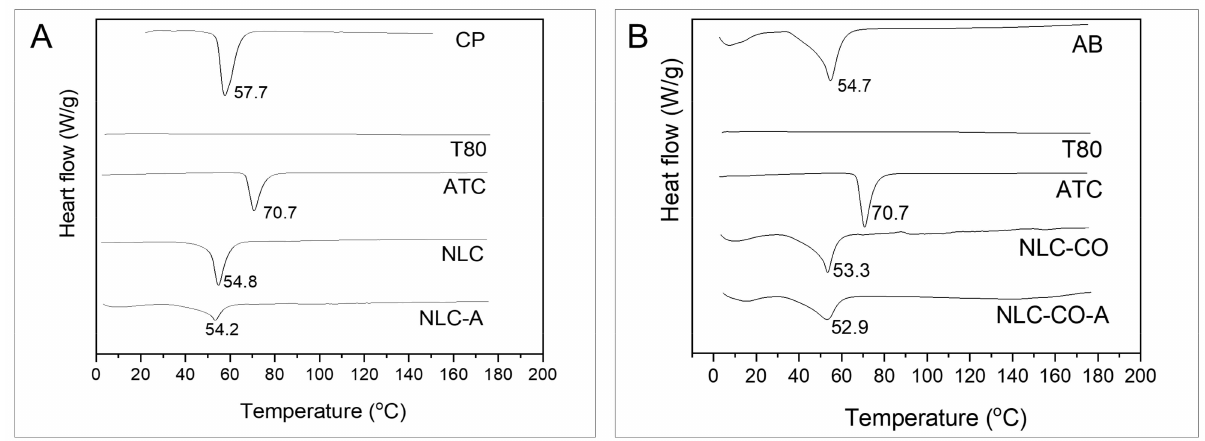
Figure 1. DSC thermograms obtained at a heating rate of 10 ◦ C.min − 1 . ( A ) Pure cetyl palmitate (CP), Tween 80 (T80), articaine base (ATC), synthetic nanostructured lipid carriers without (NLC) and with ATC (NLC-A). ( B ) Pure avocado butter (AB), T80, ATC, NLC without (NLC-CO) and with ATC (NLC-CO-A). The scales of the samples are equal for